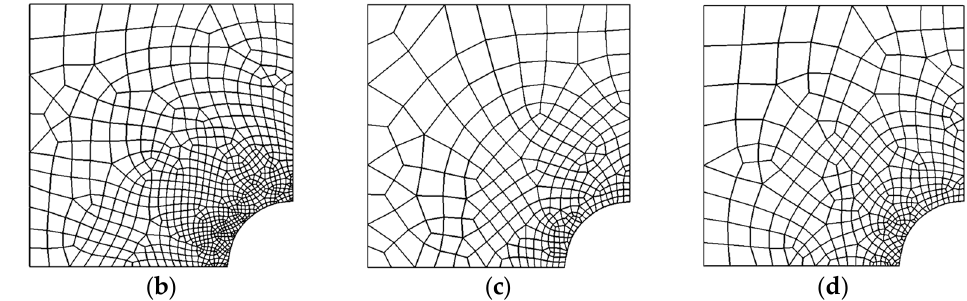
Figure 6 Refined mesh plots of incompressible plate having rigid circular opening with RPI-recov- ery techniques considering influence zones and conventional patches (quadrilateral elements orig- inal mesh =233, 2% target accuracy). ( a ) Mesh (original). ( b ) LS (conventional patch). ( c ) RPI (influence zones, MQ, cirular). ( d ) RPI (conventional patch,